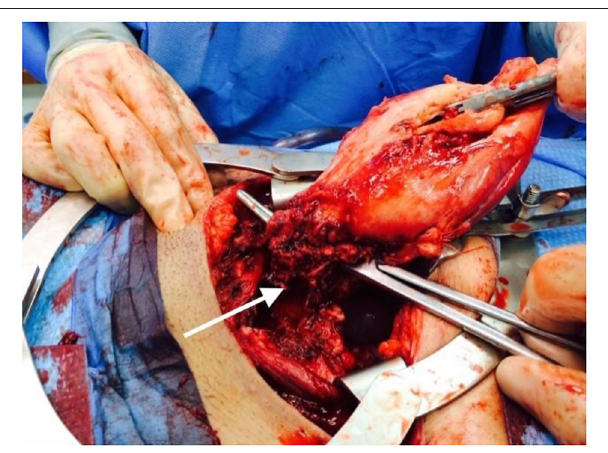
FIGURE 2 | Intraoperative photo from 2014 total hysterectomy. The arrow points to a necrotic area at the uterine base. wound healing and sterile sepsis. Despite the severity of these complications, a clear immune defect was not discernable.